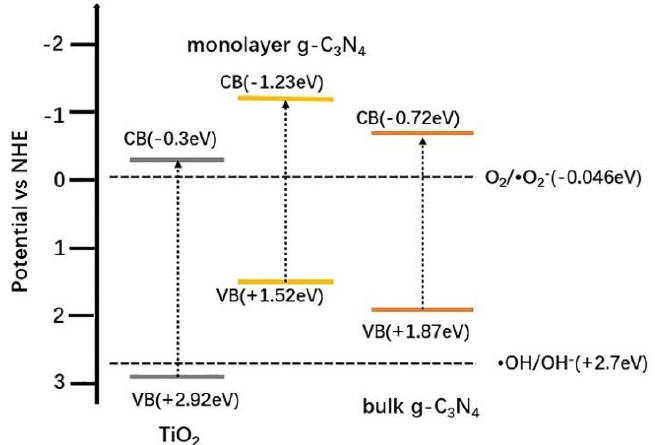
Figure 12. Bandgaps of TiO 2 , monolayer g-C 3 N 4 and bulk g-C 3 N 4.